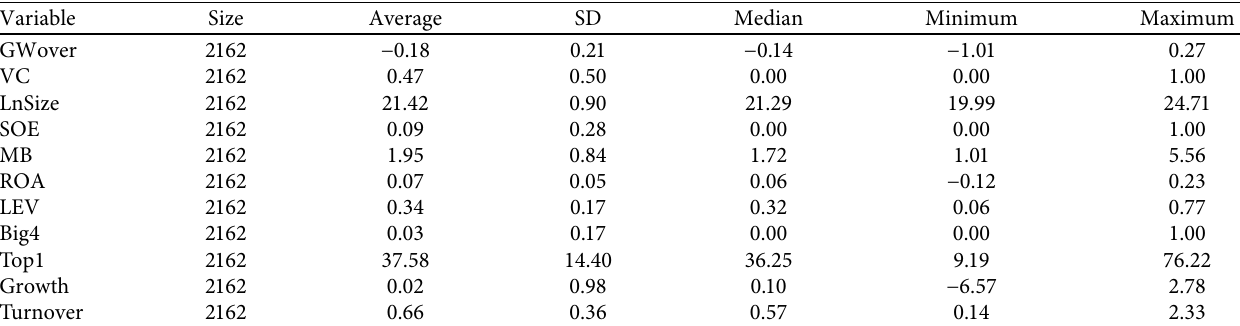
Table 2: Variable descriptive